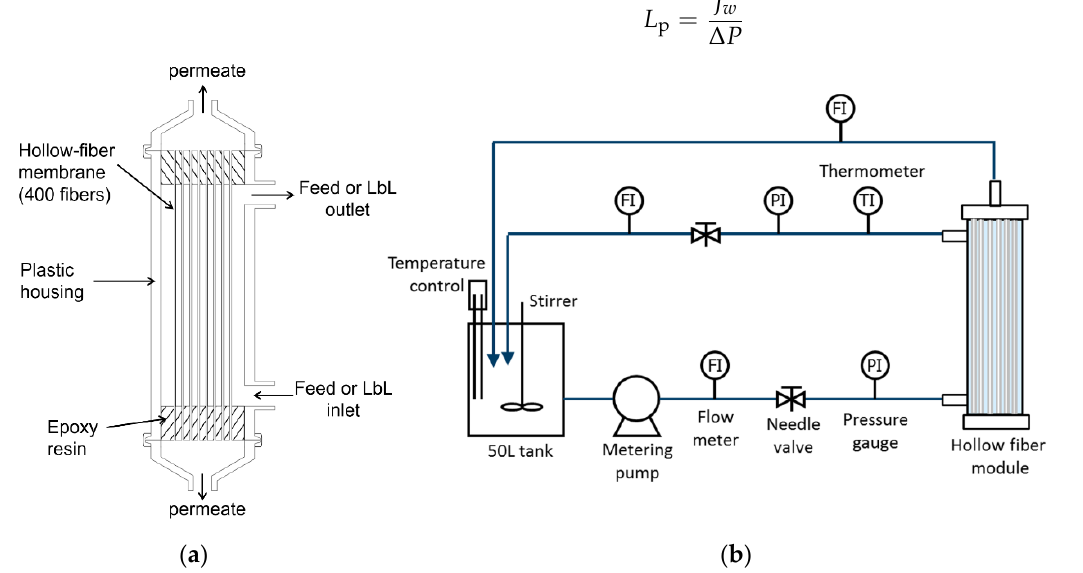
Figure 1. A schematic representation of ( a ) the hollow-fiber membrane module and ( b ) the crossflow evaluation set-up. Layer-by-Layer (LbL) and cross-linking treatments were performed inside the hollow-fiber